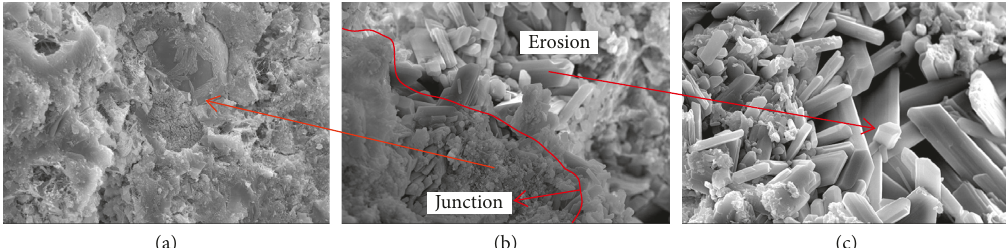
Figure 9: Photomicrographs of SEM of acid corrosion concrete specimen: (a) centre of the specimen with magnification 1500x; (b) junction of the specimen with magnification 1500x; (c) erosion of the specimen with magnification